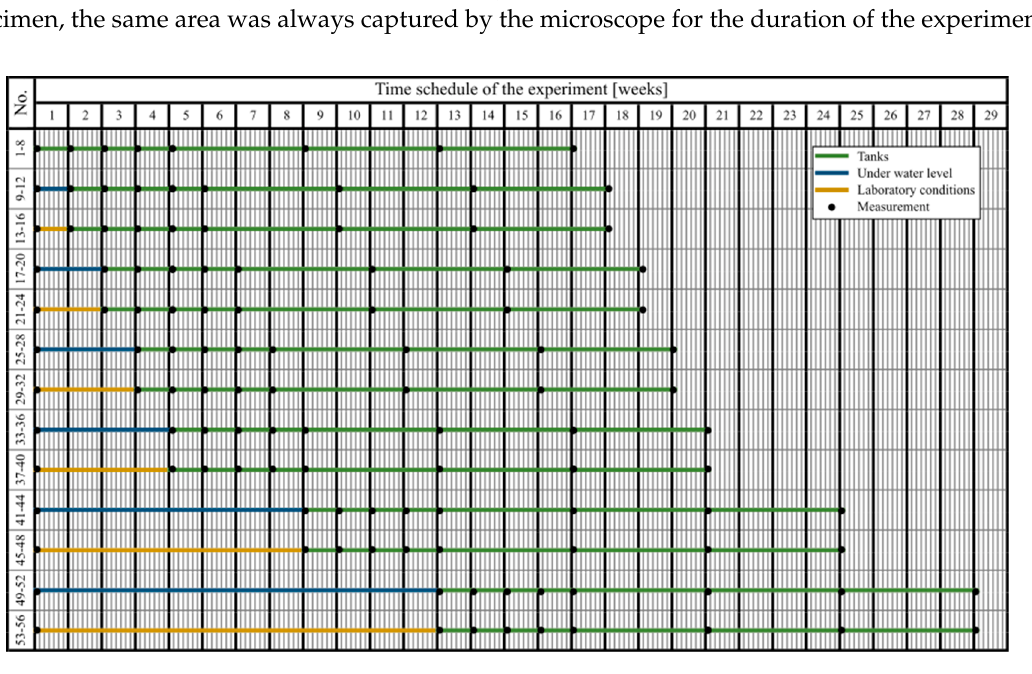
Figure 5. Storage of test specimens in the second phase. Figure 6. Specimens in tanks during the second phase. The last phase was focused on comparing the effectiveness of the crystalline admixture depending on the type of used cement. Two types of cement were tested, CEM I (Table 5) in the preliminary test, and CEM II in the first phase and the second phase. A total of 12 test specimens with dimensions of 50 × 50 × 10 mm 3 were produced, i.e., a total of two sets of test specimens of three pieces each for each type of cement, and the corresponding number of reference specimens, were made.